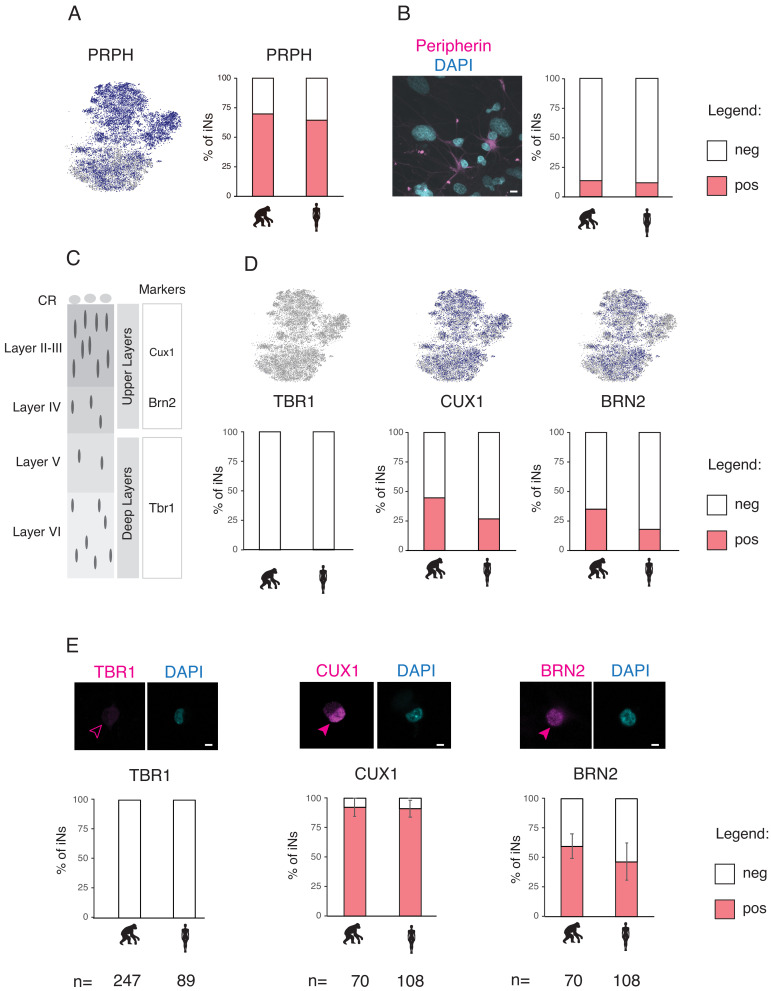
NGN2 induces cortical sensory neuron fates.The cell identity and the culture heterogeneity of the iNs was assessed by immunofluoresce and mRNA expression analyses for peripheral, cortical, and sensory markers (A) mRNA expression of the peripheral marker Peripherin (PRPH) in iNs. 70% of the iNs were found the express PRPH mRNA. (B) 12% of iNs were found to be immuno-positive for PRPH protein (magenta). (C) Marker genes for cortical layers (CUX1 for layers II–IV, BRN2 for layers II–II, and TBR1 for layers V–VI). (D) mRNA expression of the cortical markers TBR1, CUX1, and BRN2 in iNs. iNs were negative for TBR1, 27–45% of the iNs expressed CUX1 mRNA, and 18–35% BRN2 mRNA. (E) Immunofluorescence of the cortical marker proteins TBR1, CUX1, and BRN2 (magenta) in iNs. iNs were negative for TBR1, 90% of the iNs were immune positive for CUX1, and 50–60% were immune positive for BRN2. Scale bars are 10 µm. A Tukey's post hoc test revealed no significant pairwise differences between the species (see Supplementary file 6).